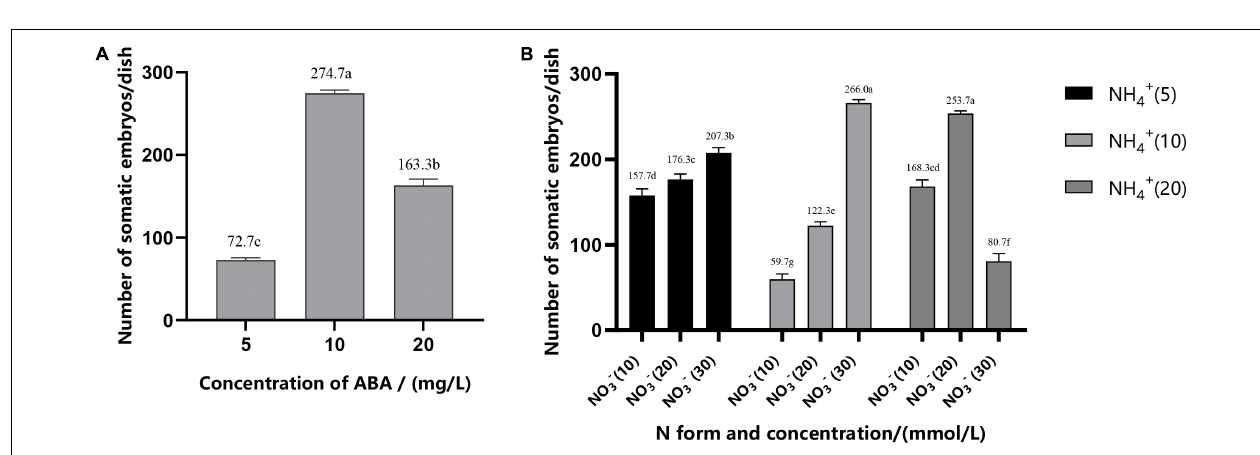
FIGURE 4 | The effect of revolutions per minute (rpm) on the change curves of somatic embryogenic calli (EC) in Pinus elliottii × Pinus caribaea in pH (A) , fresh weight (B) , and dry weight (C) over time.